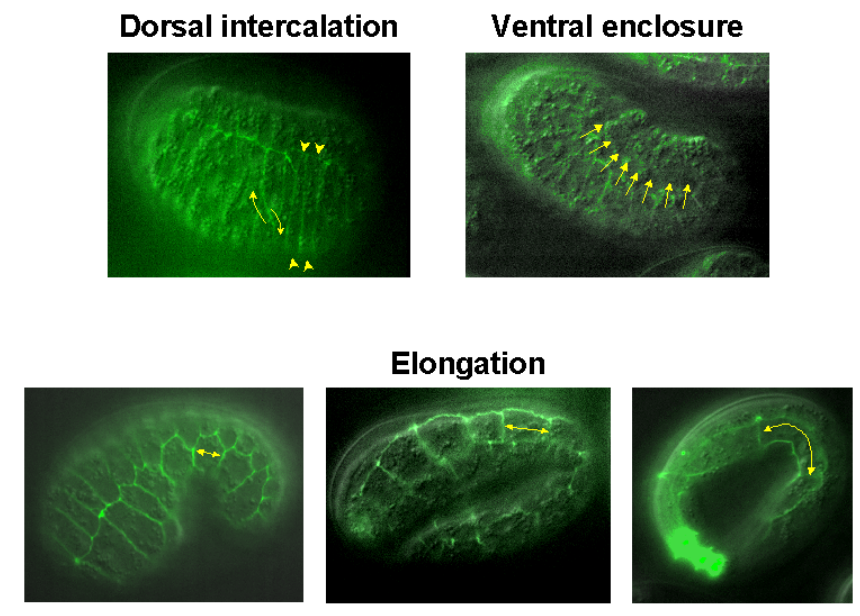
FIGURE 2. Nomarski images of living embryos expressing AJM-1::GFP (green fluorescent protein) at different morphogenetic stages. AJM- 1::GFP (green) outlines the epidermal cells. A dorsal/lateral view of an embryo during the latter stages of dorsal intercalation is shown [top left]. A pair of wedge-shaped intercalating dorsal cells are moving past one another as indicated by the arrows. The adjacent pair of fully interdigitated cells are marked by the arrowheads. A lateral view of an embryo undergoing ventral enclosure is shown at the top right. The leading edge ventral epidermal cells are migrating toward the ventral midline as indicated by the arrows. Lateral views of embryos at various stages of elongation are shown in the bottom row. An arrow in a representative lateral epidermal “seam” cell at each stage highlights how these cells are lengthening along the anterior/posterior axis as elongation progresses (the bright anterior GFP signal is the